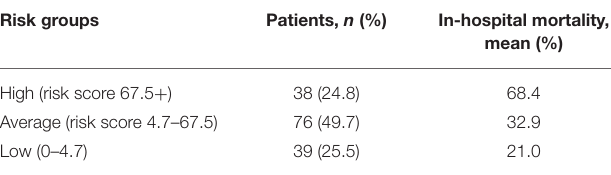
TABLE 2 | Patients risk stratification based on risk